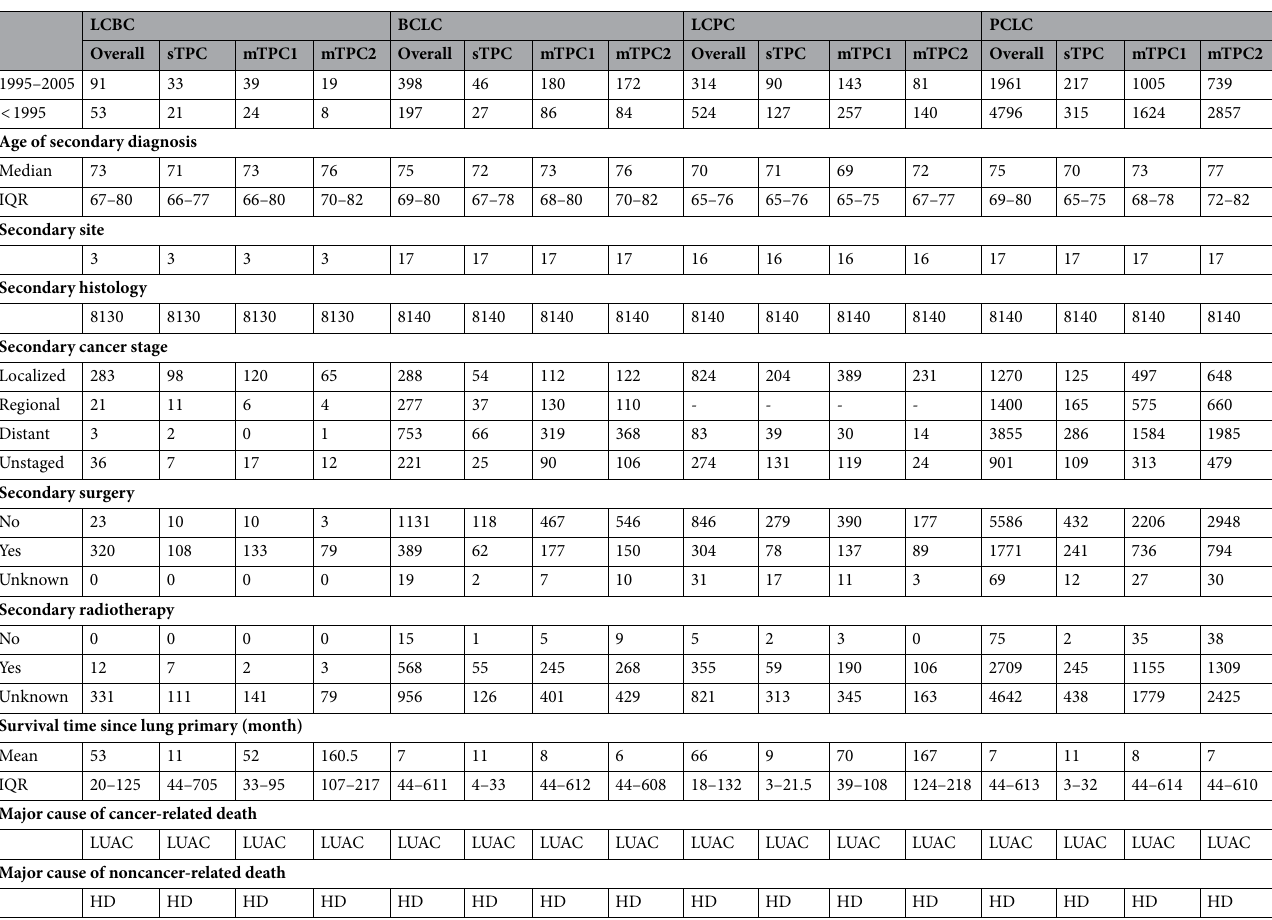
Table 1. characteristics of two primary cancer. LCBC lung cancer with subsequent bladder cancer; BCLC bladder cancer with subsequent lung cancer; LCPC lung cancer with subsequent prostate cancer; PCLC prostate cancer with subsequent lung cancer; NHW non-hispanic white; NHB non-hispanic black; NHA non- hispanic asian or pacific islander; histology 8140 adenocarcinoma; histology 8130 papillary transitional cell carcinoma; site 3 bladder; site 16 prostate; site 17 lung and bronchus; LUAC lung adenocarcinoma; HD heart